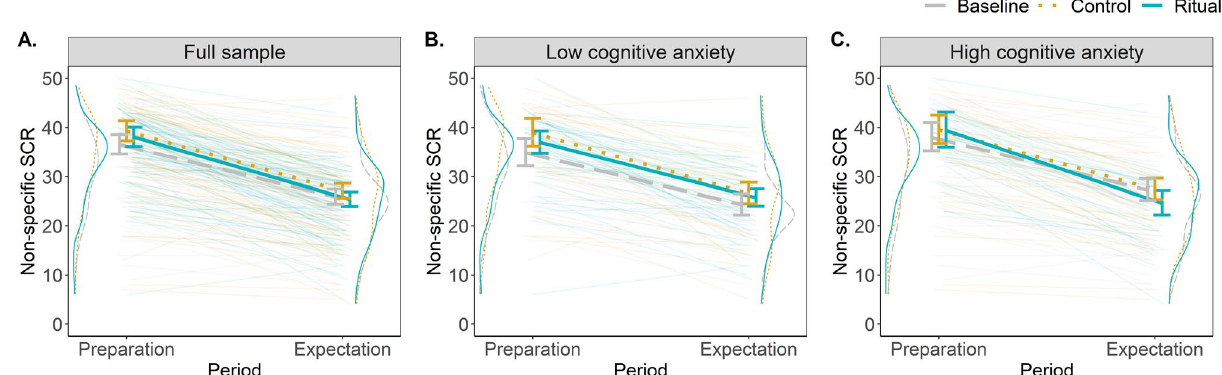
Figure 4. Estimated between-condition differences for the physiological measure of anxiety on the full sample ( A ), on the half of the sample with lower cognitive anxiety ( B ), and on the half of the sample with higher cognitive anxiety ( C ). Each plot includes density curves representing the raw distribution of data per each period and condition; raw data from all participants illustrating the dynamics of physiological anxiety; and estimated slopes with 95% CI for the between-condition differences. Data include the motor and verbal